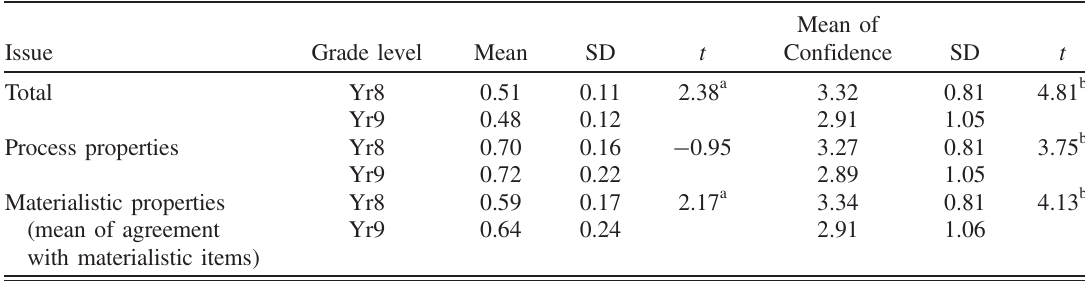
TABLE V. Grade differences [Yr8 N ¼ 614 (83.88%); Yr9 N ¼ 118